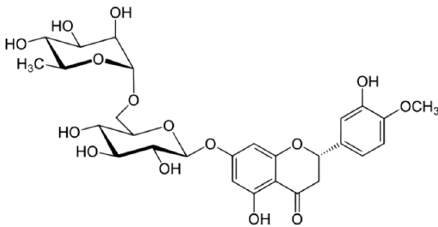
Figure 4. Chemical structure of hesperidin.